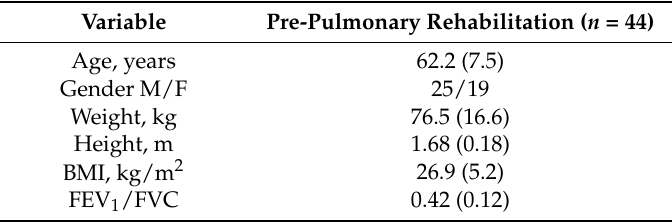
Table 1. Patient demographic characteristics at